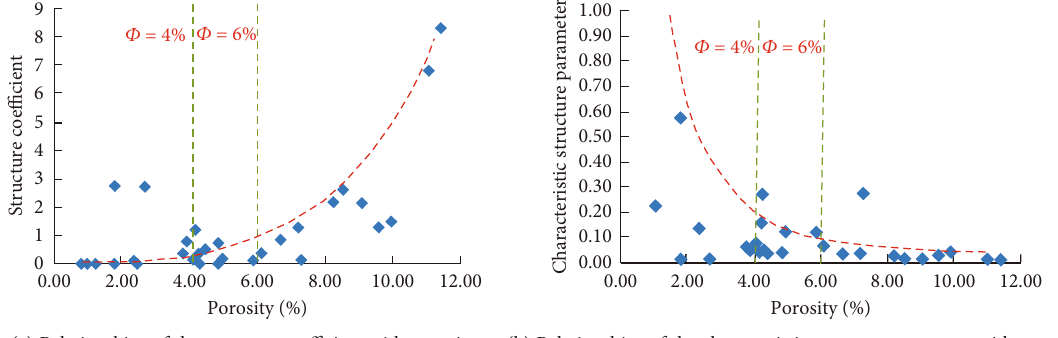
Figure 6: Relationships of the structure coe ffi cient and the characteristic structure parameter with porosity. ((a) Relationships of the structure coe ffi cient with porosity. (b) Relationships of the characteristic structure parameter with